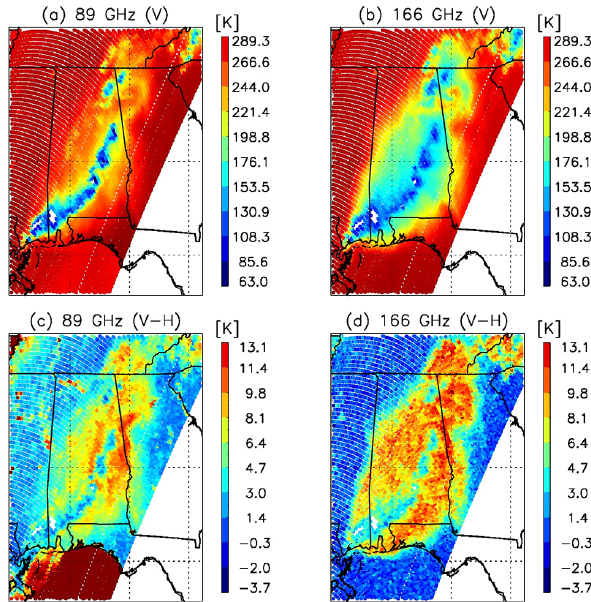
Figure 1. A squall line event on 29 April 2014 passing through the southeastern US as observed with GMI 89GHz (left panels) and 166GHz (right panels) polarimetric channels. The GMI observed radiance distributions and polarimetric differences (PDs) are shown at the top and bottom, respectively. The dark-red area over the ocean in panel (c) greatly exceeds the color scale, with values mostly in the range of 16–29K. They are presented by the black open dots in Fig.